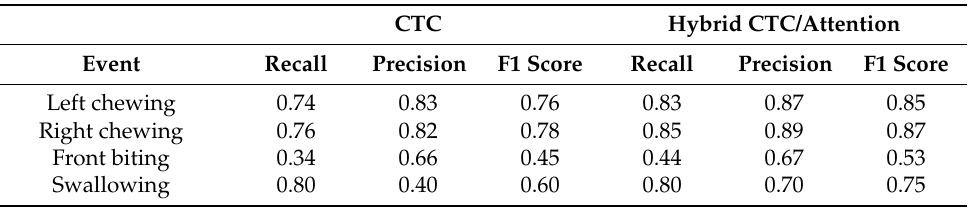
Table 2. Per-event detection performance by model (closed food): Five-class detection (left chewing, right chewing, front biting, swallowing, and others).